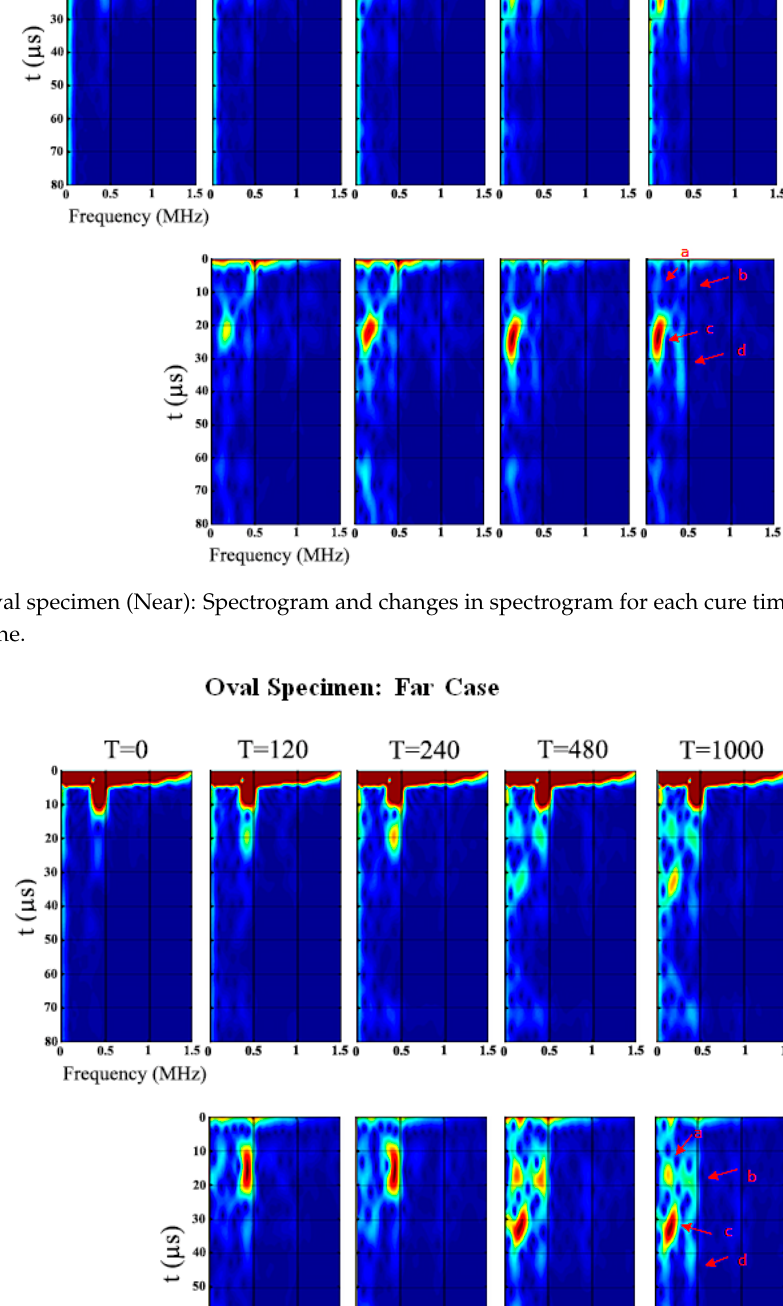
Figure 8. Oval specimens ( a ) Near and ( b ) Far: Change in frequency spectrum for each cure time relative to the baseline.